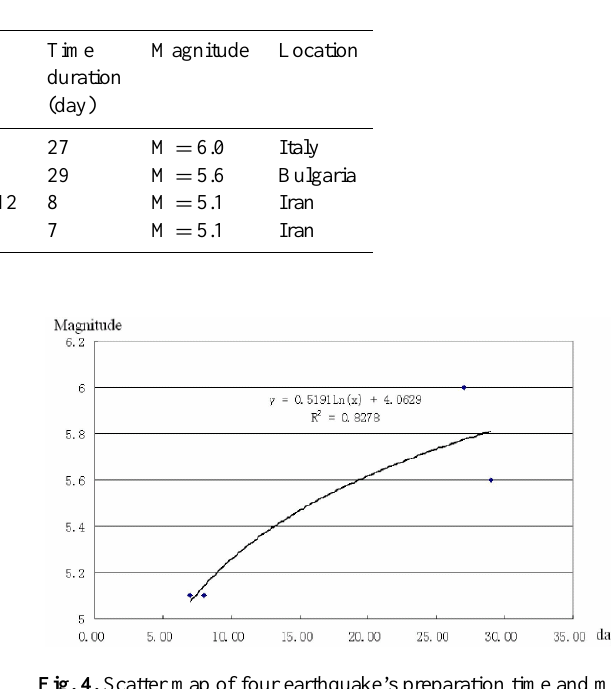
Table 2. Lists of four earthquake dates and magnitudes.